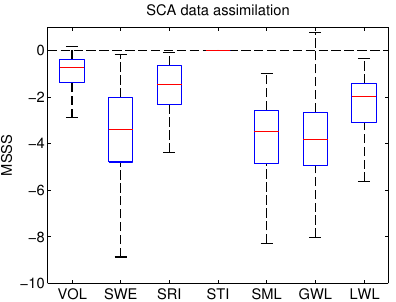
Figure 8. Box plot of the mean square skill score for each variable when assimilating basin-wide snow cover area. The open loop is used as a reference. Outliers are not shown for visibility